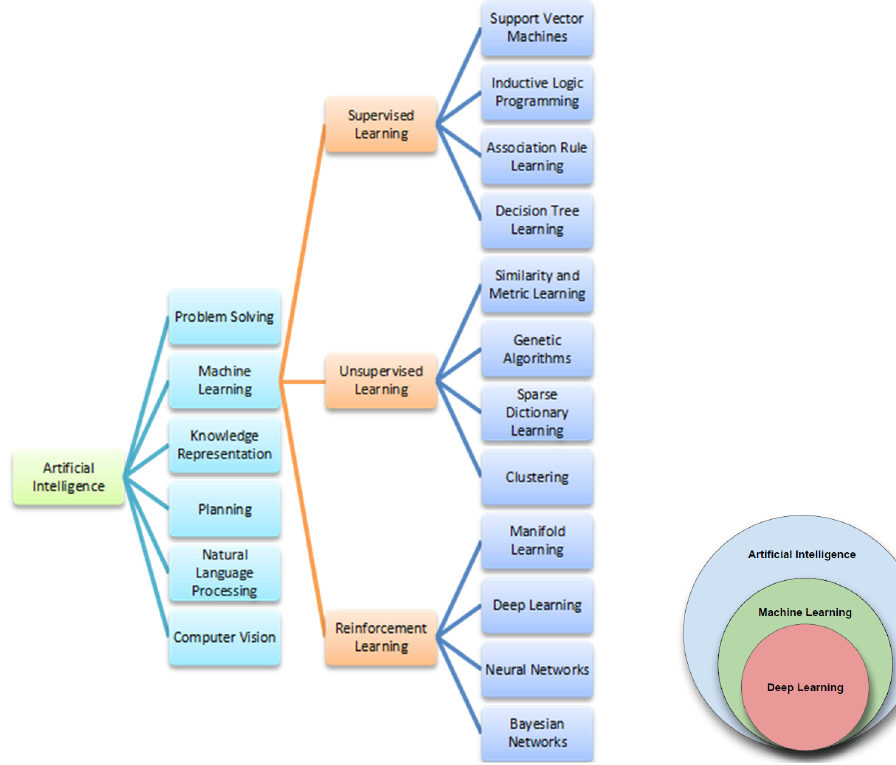
Figure 1. AI main fields are depicted in Figure 1. Machine learning is the heart of AI, and its more promising research area is represented by so-called deep learning, an evolution of the artificial neural network basic